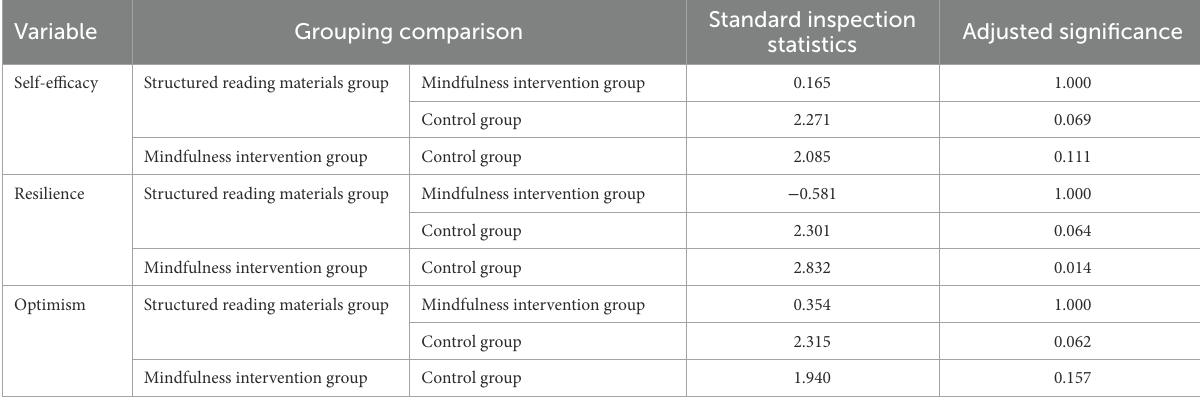
TABLE 9 Calibration test based on Bonferroni method.